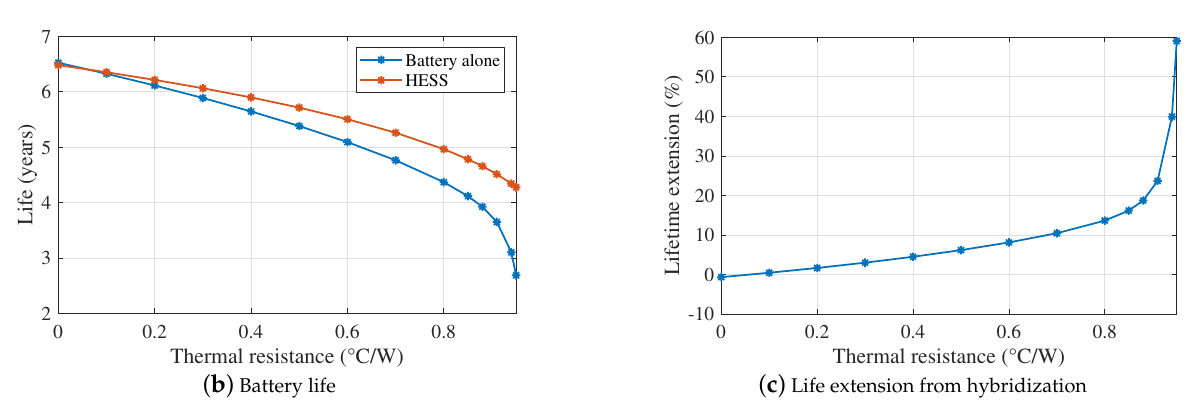
( a ) Sorted values of battery temperature for different R